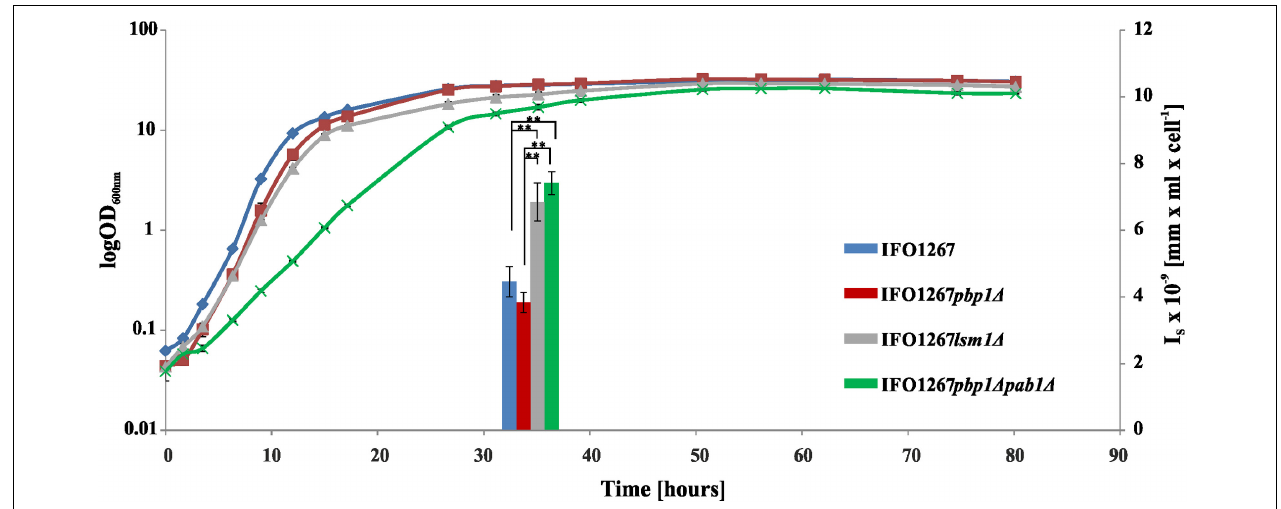
FIGURE 14 | Production of the K. lactis killer toxin is enhanced in LSM1 and PAB1 deletion strains. Growth curves and production of the pGKL1 killer toxin from the K. lactis IFO1267 (blue), IFO1267 pbp 1 (cid:49) (red), IFO1267 lsm1 (cid:49) (gray), and IFO1267 pbp1 (cid:49) pab1 (cid:49) (green) strains. All strains were grown in YPD medium at 28 ◦ C for approximately 80 h, and their OD 600 nm and toxin production were monitored. Production of the pGKL1 killer toxin in culture medium was assayed by a well diffusion test on YPD agar plates with a lawn of the S. cerevisiae S6/1 sensitive strain (for details of the method, refer to section Materials and Methods and Supplementary Figure S4 ). The toxin levels in culture media in the early stationary phase ( ∼ 35 h), when all the cultures reached a comparable OD 600 , are depicted. The amount of active toxin produced by each strain is presented as the calculated normalized inhibition zone at killer toxin saturation ( I s ). Growth curves and I s determination correspond to at least three independent replicates. The results were statistically evaluated using one-way ANOVA followed by post hoc Tukey’s HSD test and further confirmed with Scheffé multiple comparison ( ∗∗ p < 0.01). Normal distribution of the data was confirmed by the Shapiro–Wilk test. Error bars at each point on the growth curves and in the bar graph represent standard